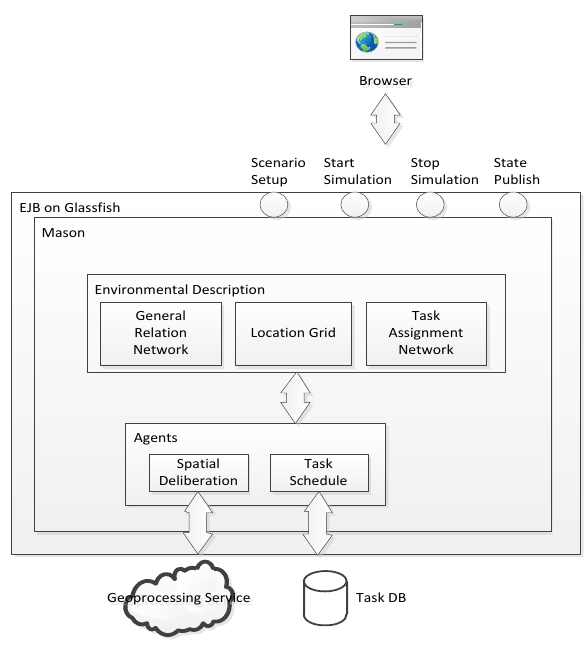
Figure 2. Simulation Service in Detail